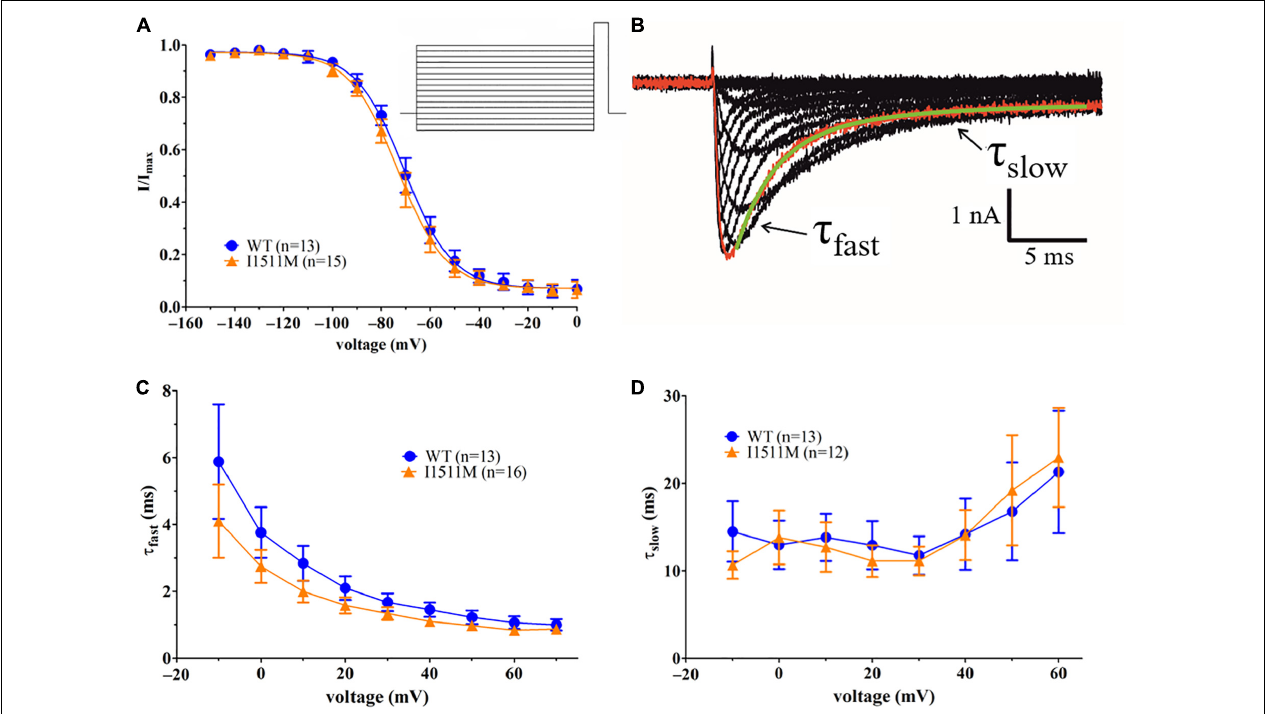
FIGURE 5 | Sodium channel fast inactivation kinetics are comparable for WT and I1511M channels. (A) Current-voltage relationship of sodium channel fast inactivation for hNa v 1.8 WT and I1511M. The voltage protocol is shown as inset. (B) Example trace for the current decay fit. The trace marked in red was fitted with a two-phase exponential decay function shown in green. The two components of the decay function with their respective decay constant are indicated by arrows. (C) Development of τ fast values over the different voltages. (D) Development of τ slow values over the different